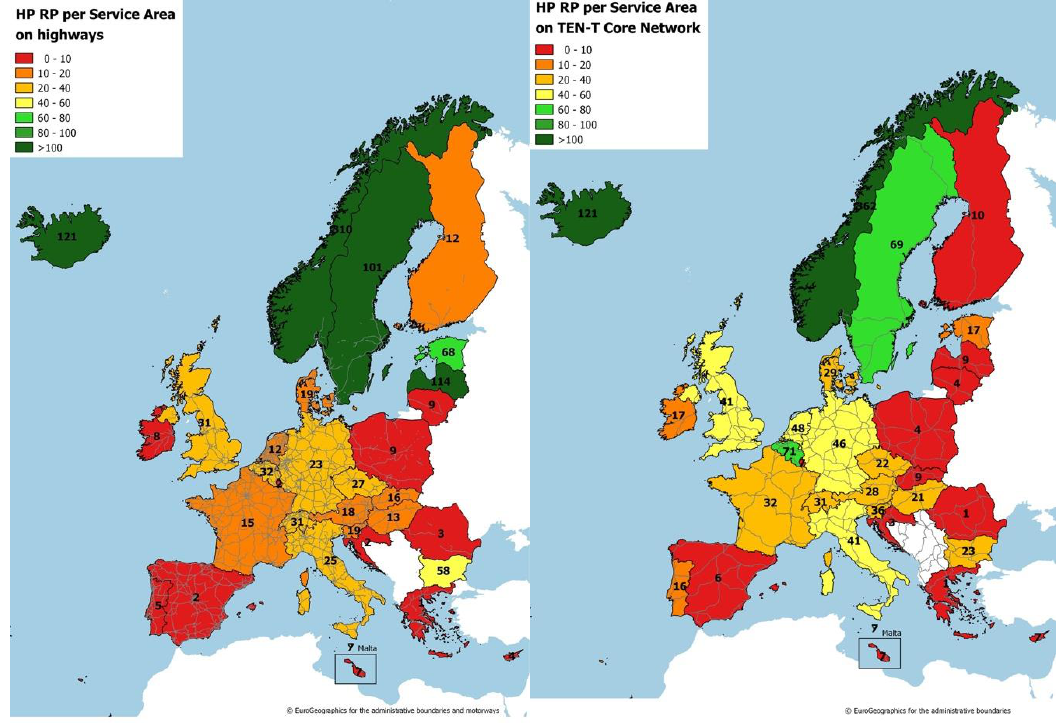
Figure 5. Average number of high power recharging points (HPRP) per ideally situated service areas on highways and Trans-European Transport Network (TEN-T) Core Network across Europe in 2020 (own elaboration on NPF data [58] and strategies of European Free Trade Association (EFTA) countries [60–62]).